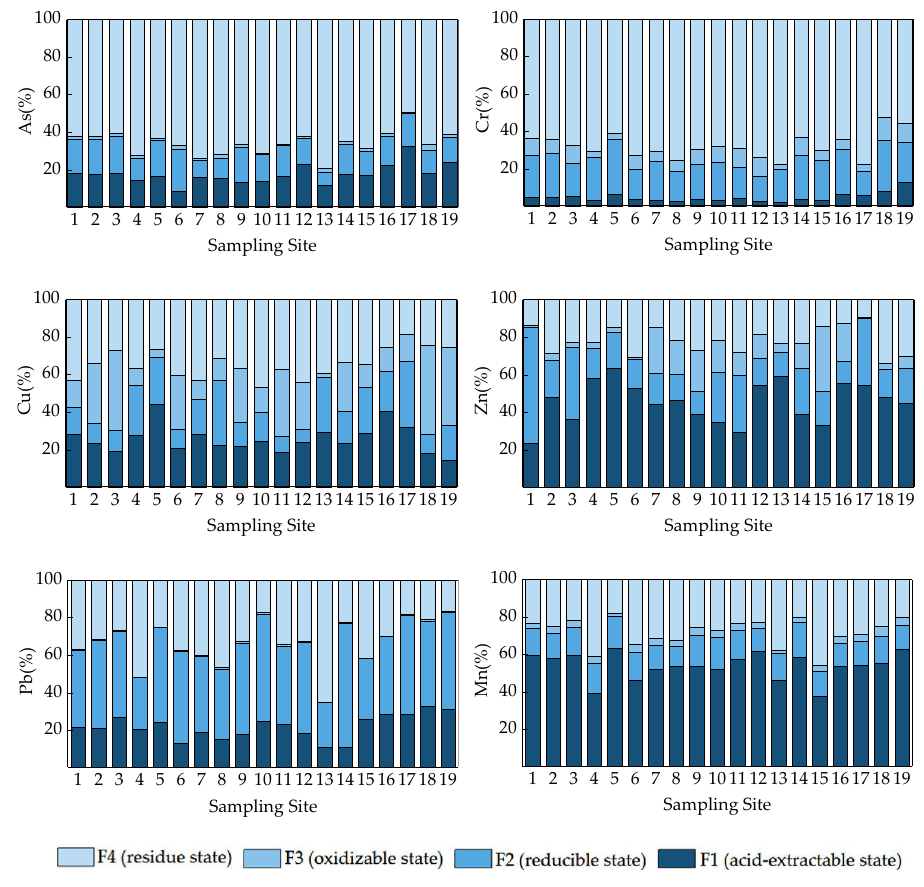
Figure 4. The percent content of various speciation of HMs in surface sediments relative to the total